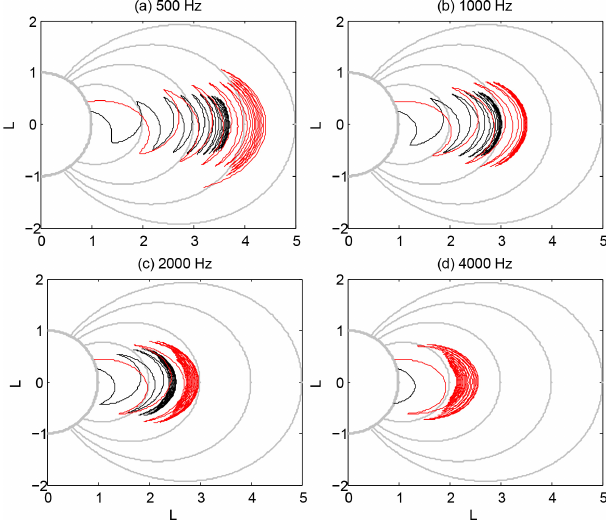
Figure 2. Ray paths of waves launched from two latitudes of 15 ◦ (black curves) and 25 ◦ (red curves), at four wave frequencies: (a) 500Hz, (b) 1kHz, (c) 2kHz, and (d) 4kHz. The initial altitude is 120km and δ is 0 ◦ for all cases. Here δ is the angle between the wave-normal vector and the radial